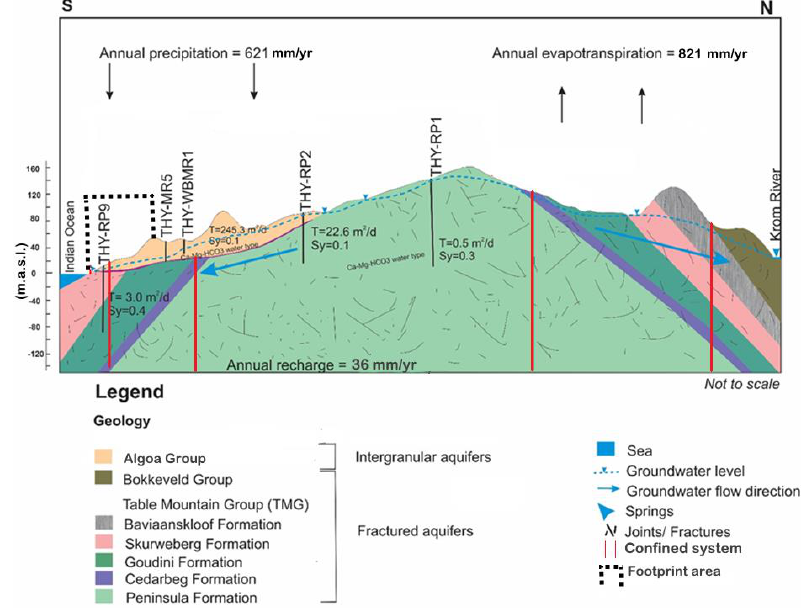
Figure 10. Hydrogeological conceptual model for the Thyspunt area, based on a south−north cross-section direction, as indicated in Figure 3.